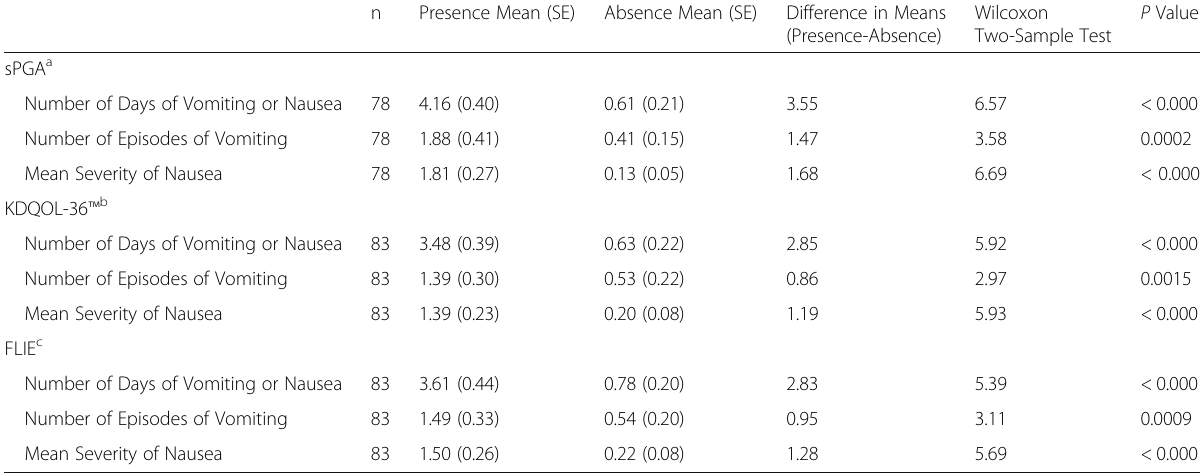
Table 6 Assessment of known-groups validity for NVSA © scores